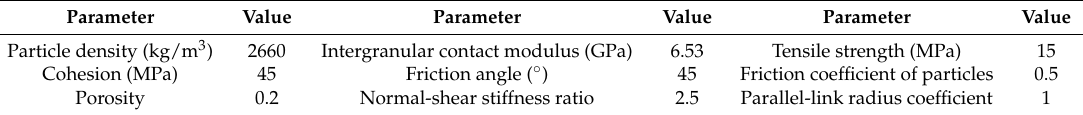
Figure 7. Internal damage model of EPB in granite. Table 2. The microscopic parameters of granite particle